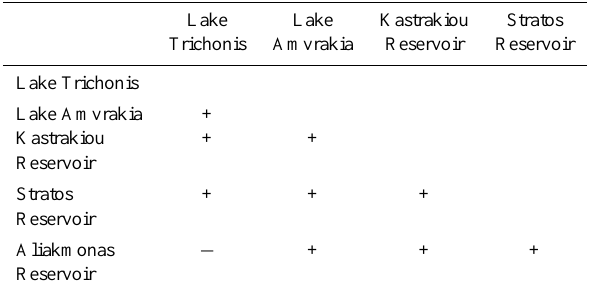
Table 4. Results of the exact test for significant pairwise genetic differences (level 0.05) in Dreissena blanci from different water bodies. Note that lakes Prespa and Pamvotis were excluded from the analysis as only a single specimen each was sampled in these